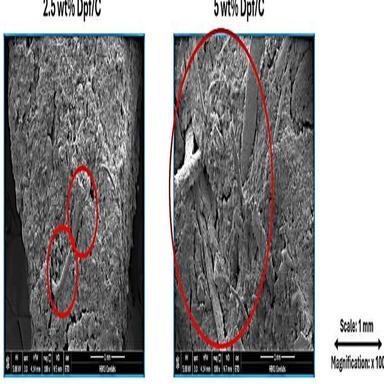
SEM images of different Dpf/C ratios and Dpf.